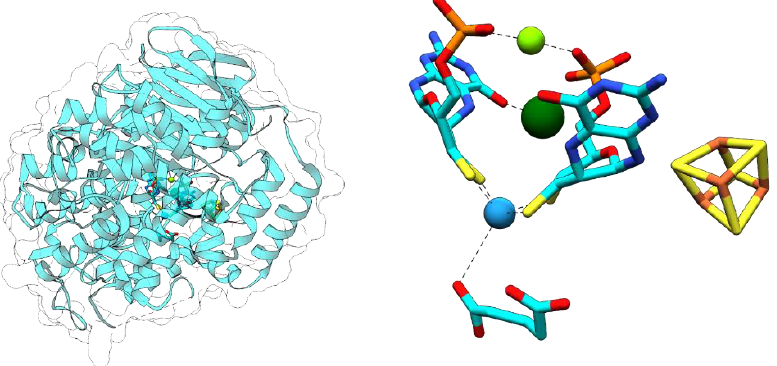
Figure 4. Structure of formaldehyde:ferredoxin oxidoreductase from P. furiosus , in complex with glutarate (pdb 1B4N) at 2.4 Å solution. Left panel: overall structure; right panel W-bis-MPT and [4Fe-4S] cofactor. The tungsten atom is depicted in blue, Mg 2 + is shown in light green, and Ca 2 + in dark